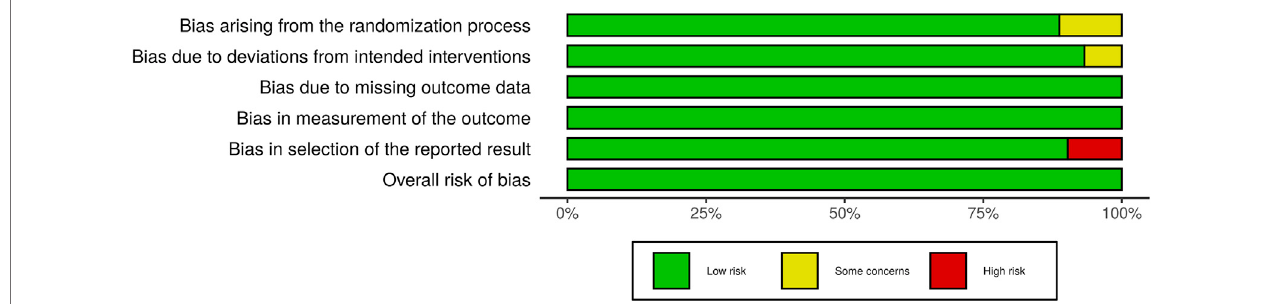
FIGURE 3 | Summary of Risk of Bias in Randomized Controlled